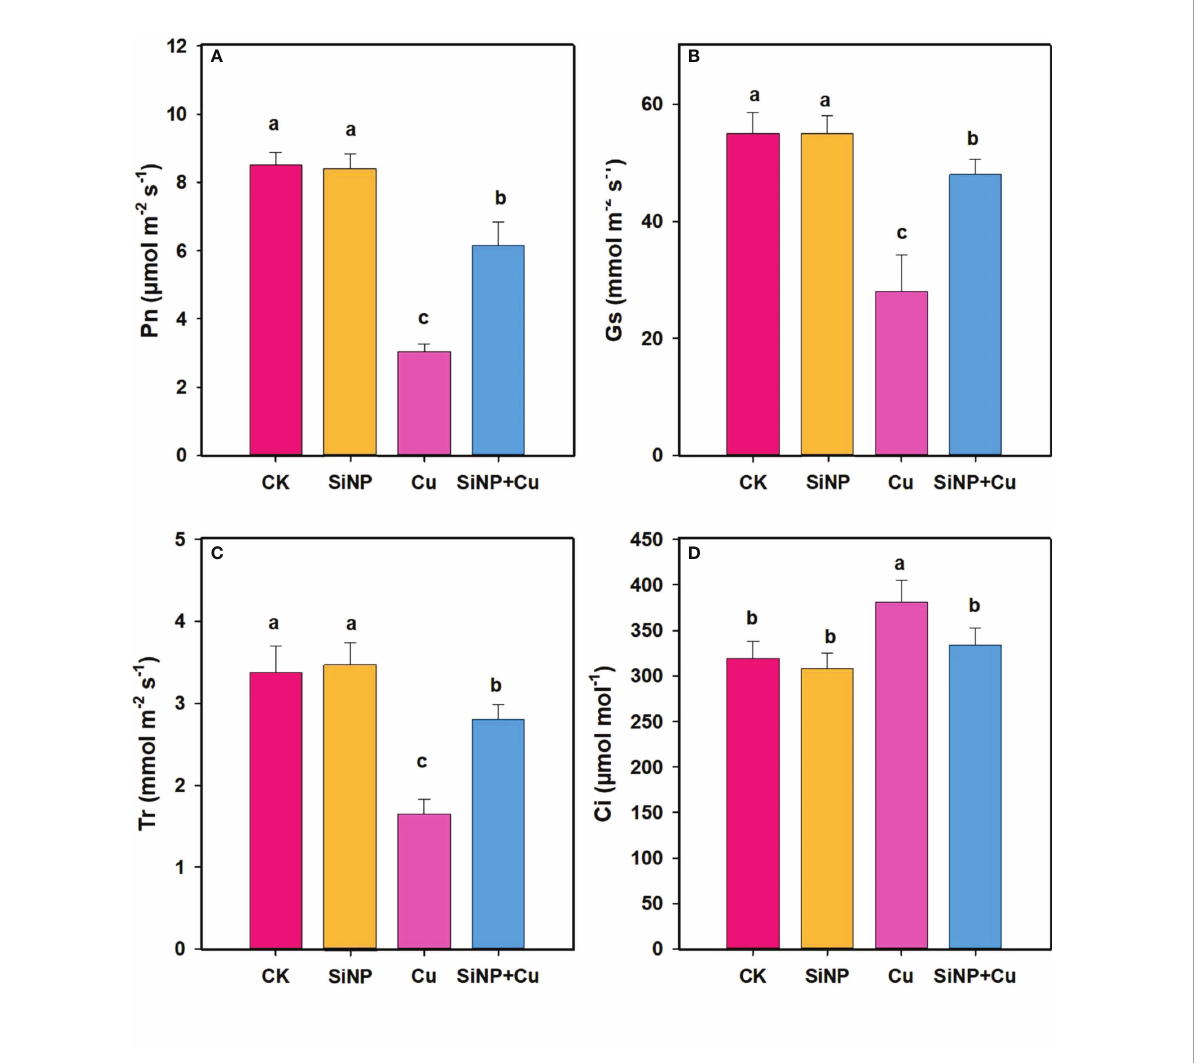
FIGURE 3 Gas exchange traits under Cu 2+ stress. Note “ Experimental treatments contained: CK (control); SiNP (2.5 mM SiNPs); Cu (500 µM Cu 2+ alone), SiNP+Cu (2.5 mM SiNPs+500 µM Cu 2+ ). The different letters (a, b, c, d) describe the differences in different treatments by LSD test at (P ≤ 0.05) ” . (A) Pn, (B) Gs, (C) Tr, (D)